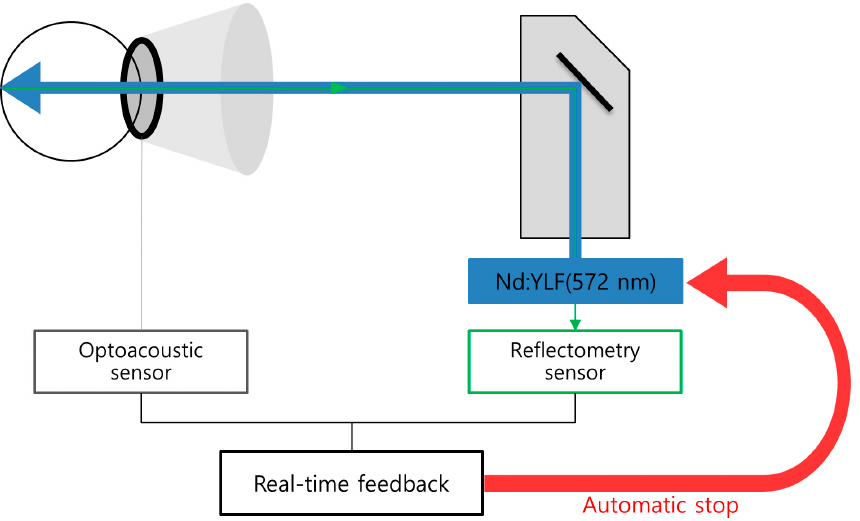
Figure 2. A schematic diagram representing the signal processing of real-time feedback-controlled dosimetry. Acoustic transient signals are detected by a contact lens with an inserted ring-shaped optoacoustic sensor and backscattered light signals are detected by a reflectometry sensor. When the acoustic or light feedback signals reach the set thresholds, irradiation stops automatically.